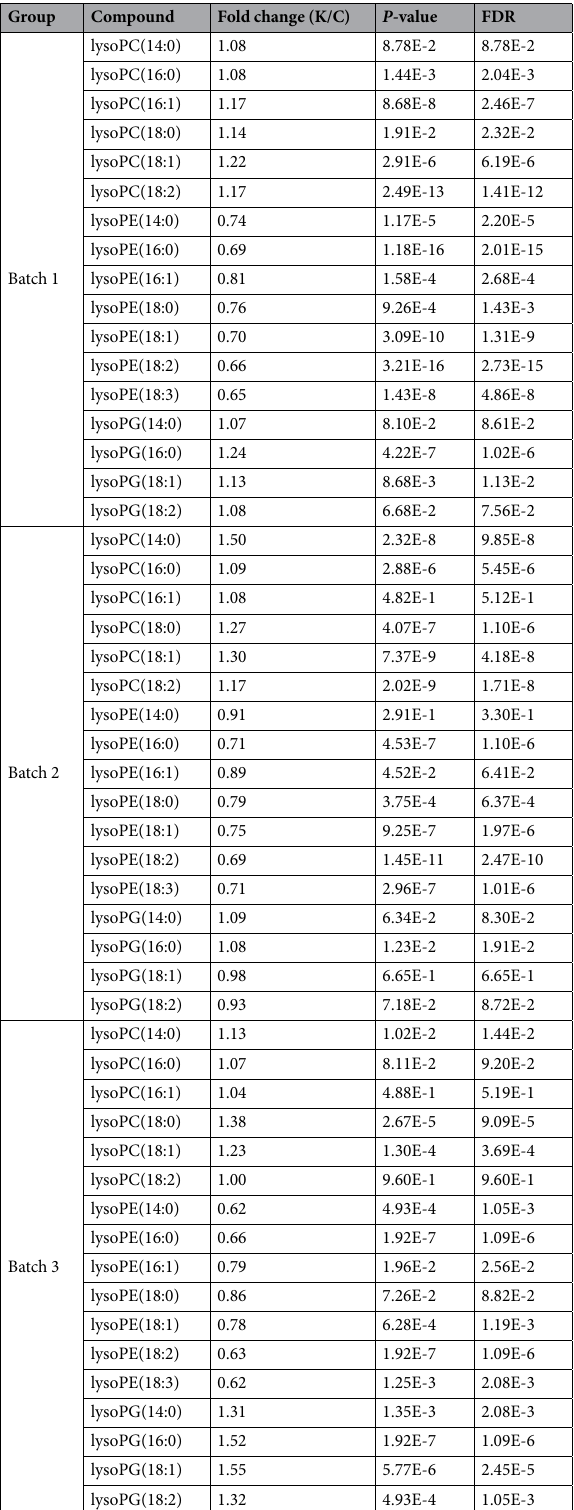
Table 2. The fold change, P -value, and FDR of 17 lysoGPLs among three different batches of